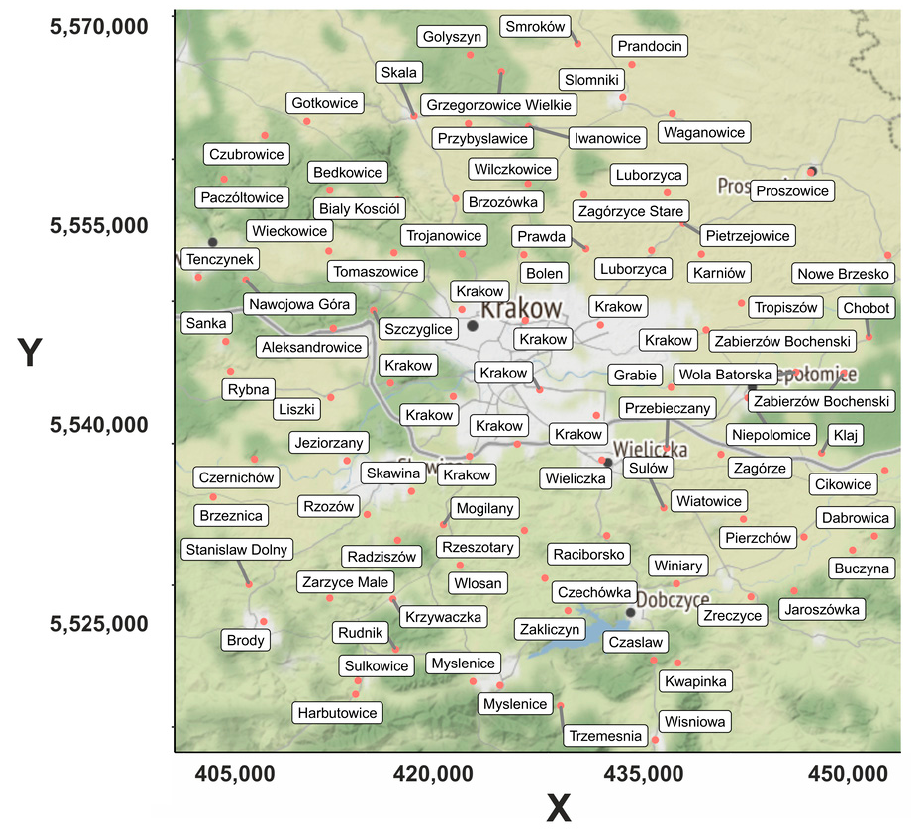
Figure 1. Locations of the Airly sensors used in the research (red dots) with the names of cities, towns, and villages in which they are located.